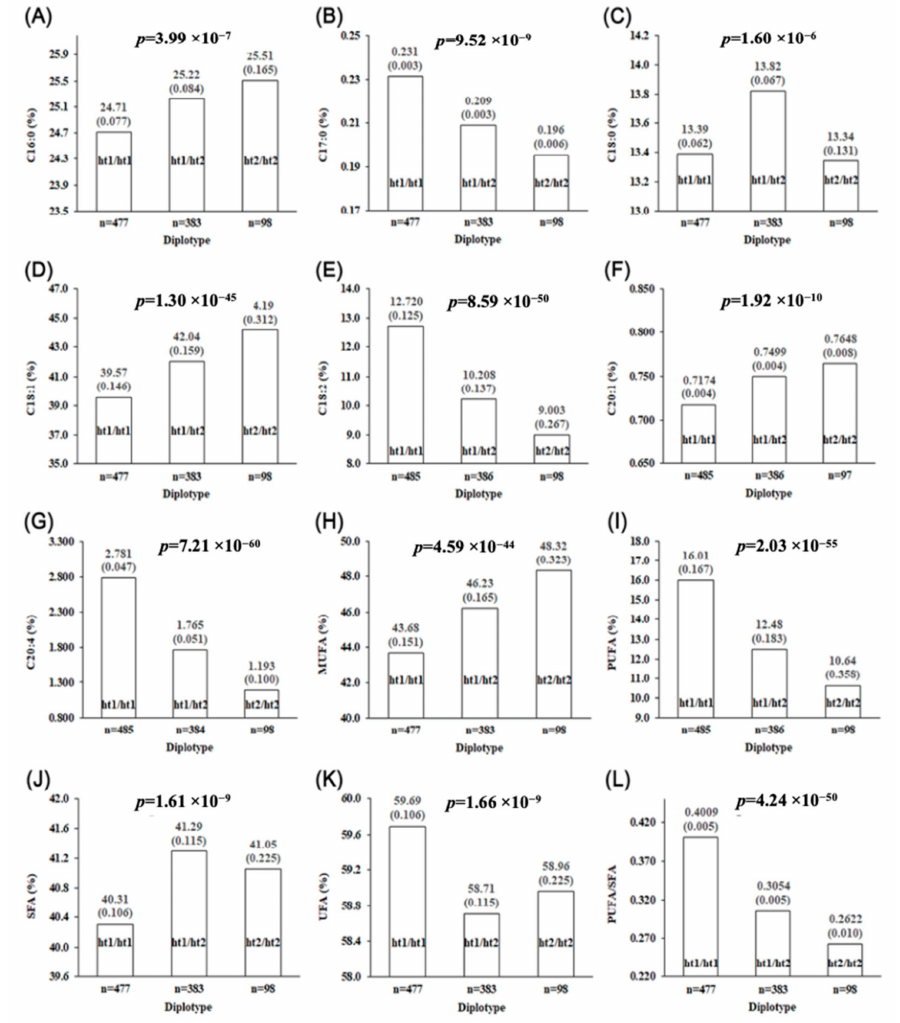
Figure 3. Haplotypic effect of the variants in GAS7, MYH2, and MYH3 genes on FA profile traits of the longissimus dorsi muscle in the LK cross ( p < 0.01). Each bar represents the least square mean of each diplotype of the FA profile traits. The number in parentheses above each bar represents the standard error. ( A ) Bar graph for C16:0; ( B ) bar graph for C17:0; ( C ) bar graph for C18:0; ( D ) bar graph for C18:1; ( E ) bar graph for C18:2; ( F ) bar graph for C20:1; ( G ) bar graph for C20:4; ( H ) bar graph for MUFAs; ( I ) bar graph for PUFAs; ( J ) bar graph for SFA; ( K ) bar graph for UFA; ( L ) bar graph for P/S